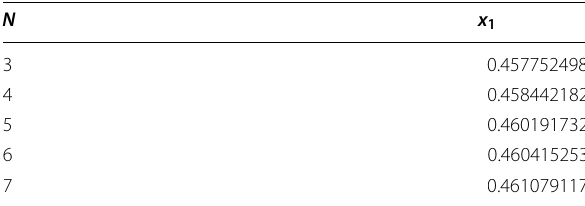
Table 5 Contact length x 1 at q = q 1 for various N The exact